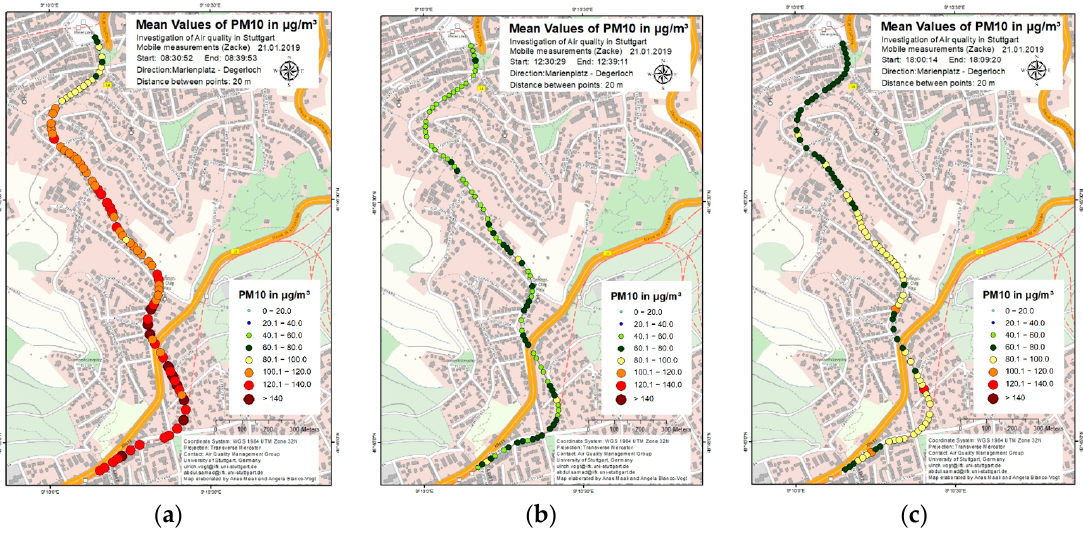
Figure 7. PM10 concentrations during three different trips ( a ) early morning, ( b ) afternoon, ( c ) evening on 21 February 2019.